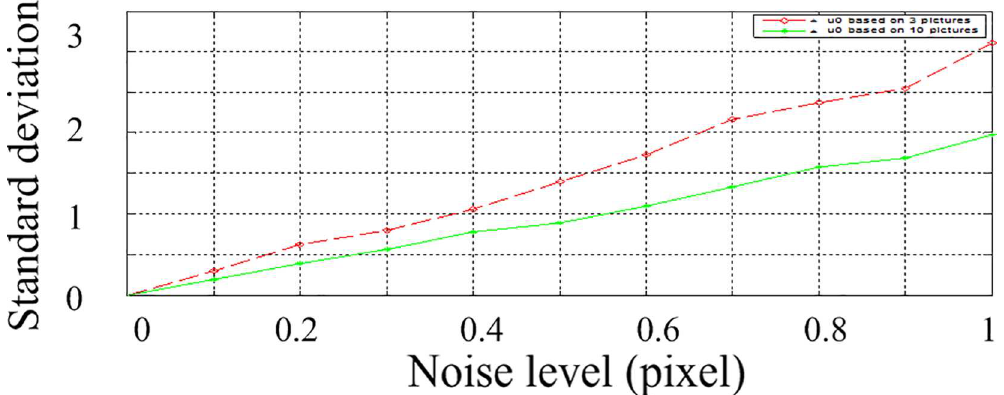
Fig 9. the standard deviations of u 0 with 3 and 10